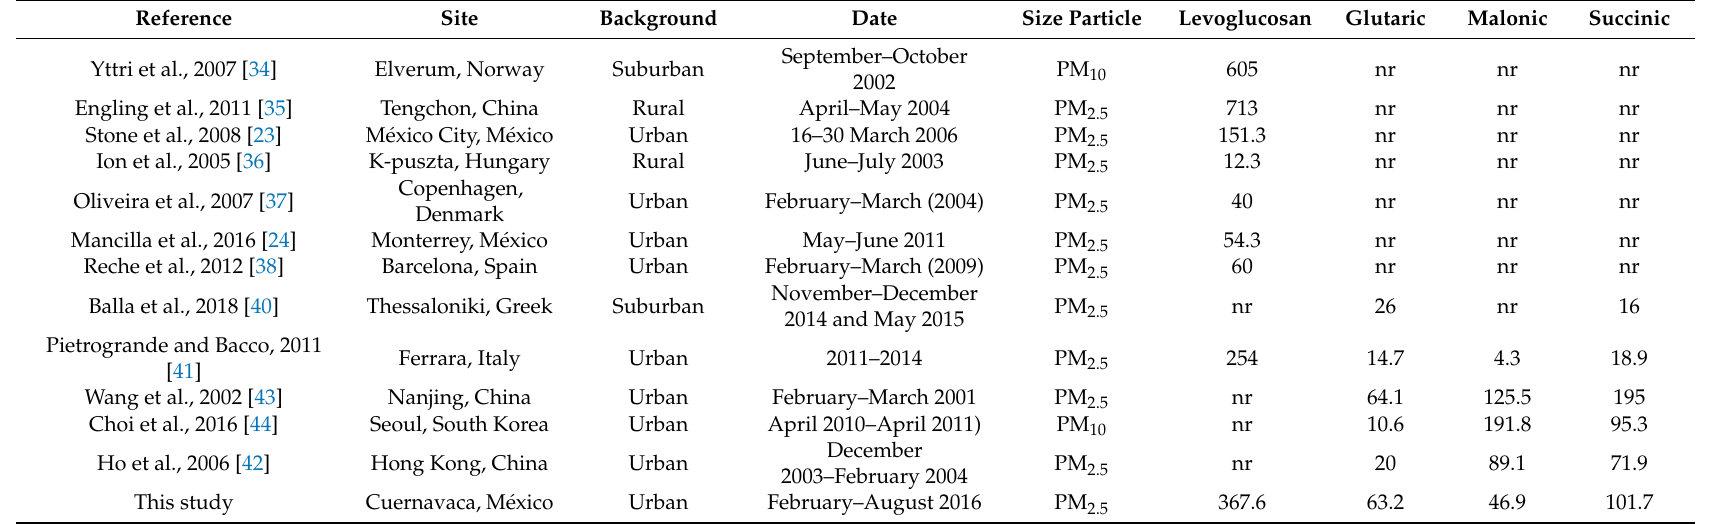
Table 6. Comparison with other studies carried out in other cities of the world, average concentration (ng m − 3